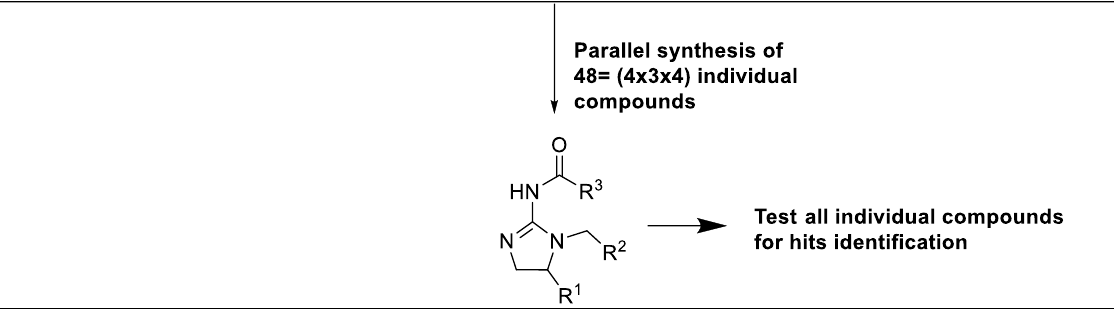
Figure 4. Deconvolution strategy of positional scanning library 1295 for hit identification.